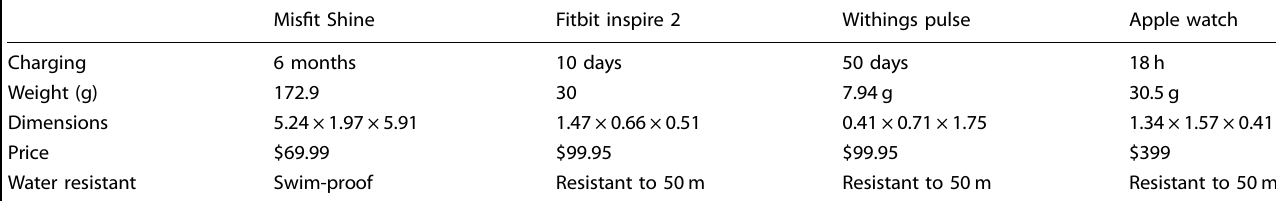
Table 1. Motion based health and fi tness